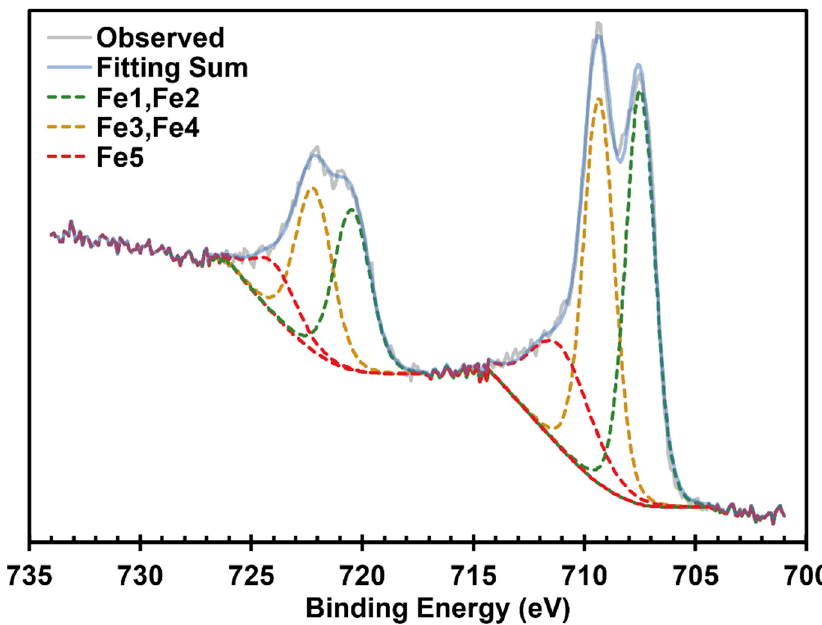
Figure 12. Observed high-resolution X-ray photoelectron spectrum (XPS) and component fitting of the iron 2 p region of cluster 5 . Image adapted with permission from Joseph, C., Cobb, C. R., Rose, M. J. Single-Step Insertion of Sulfides and Thiolate into Iron Carbide-Carbonyl Clusters: Unlocking the Synthetic Door to FeMoco Analogues. Angew. Chemie Int. Ed. 2020 , Accepted, not yet published . Reproduced with